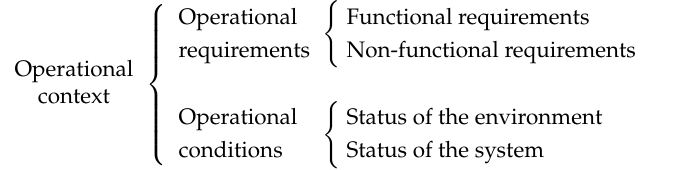
Figure 1. Definition of operational